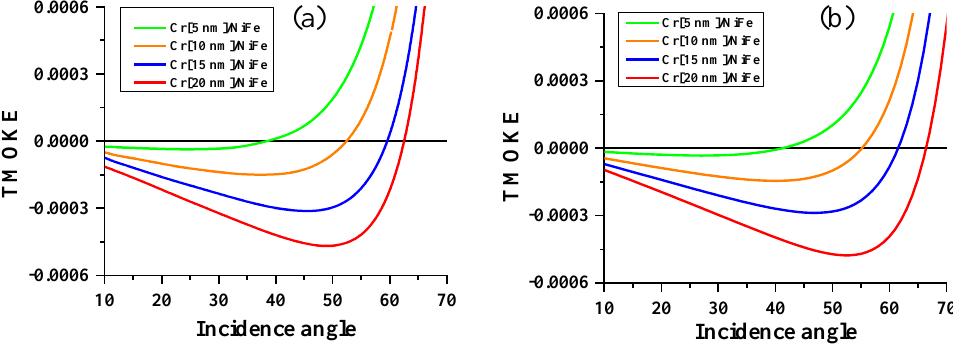
Figure 6. Maximal TMOKE signal δ max vs. incidence angle θ 0 for the Cr / NiFe films with di ff erent thicknesses of the Cr layer and with the thickness of the NiFe layer fixed to 10 nm: ( a ) experimental plots and ( b ) theoretical plots. The theoretical curves are obtained using the deduced results of optical parameters from the ellipsometry